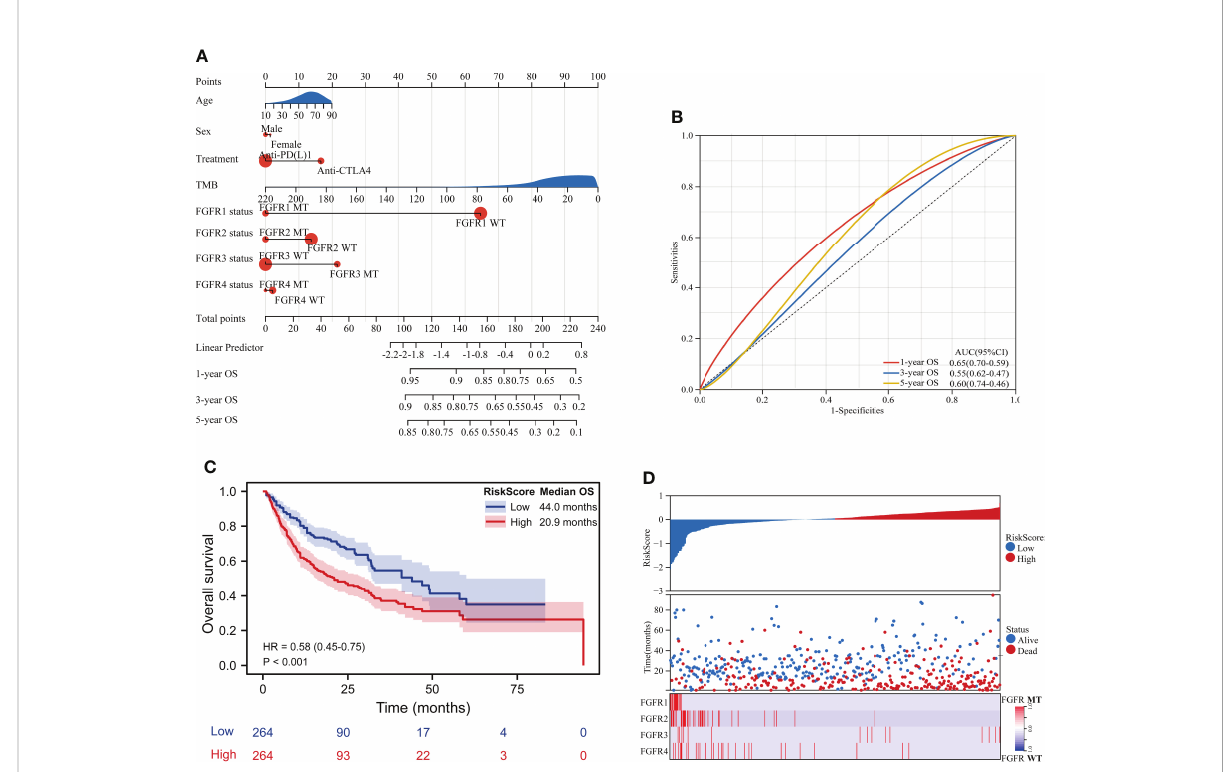
FIGURE 5 Construction of the nomogram to predict survival of melanoma patients. (A) A nomogram integrating clinicopathological variables including age, sex, ICIs categories, TMB, and FGFR1/2/3/4 status to predict the 1-year OS, 3-year OS and 5-year OS of patients in ICIs-treated cohort. (B) The ROC curve showed the predictive performance of the nomogram. (C) Survival curve of OS for patients from the ICIs-treated cohort based on risk score. (D) The risk score map exhibited the risk score level, survival status and FGFR status for each patient from the ICIs-treated